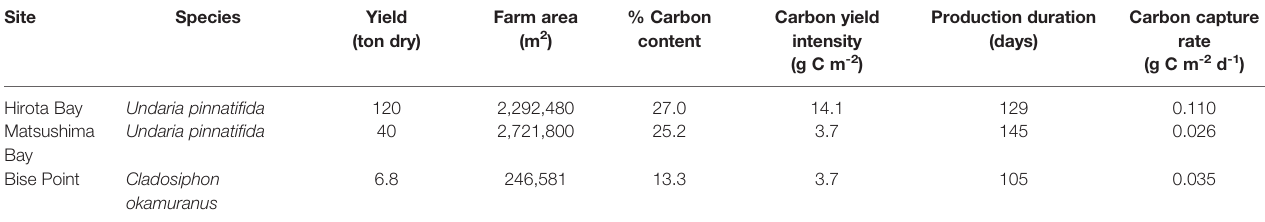
TABLE 4 | The total yield and estimated amount of carbon captured by the seaweed farms at Hirota Bay, Matsushima Bay, and Bise Point during their respective cultivation season.